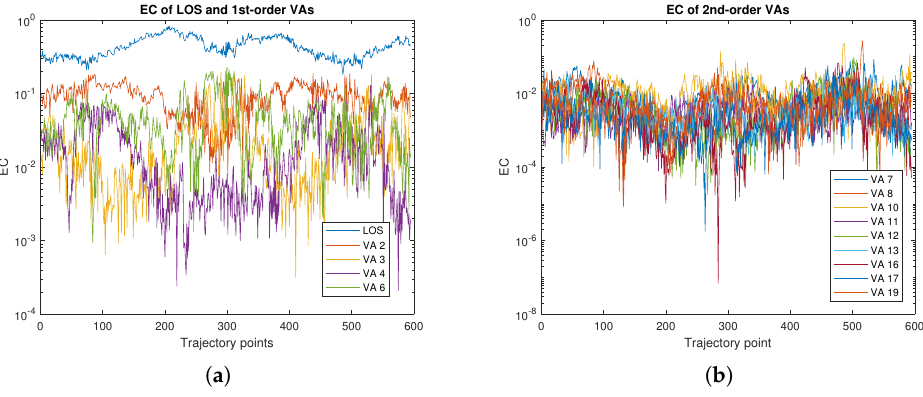
Figure 4. EC of individual SMC: ( a ) VA 1 to VA 6, ( b ) VA 7 to VA